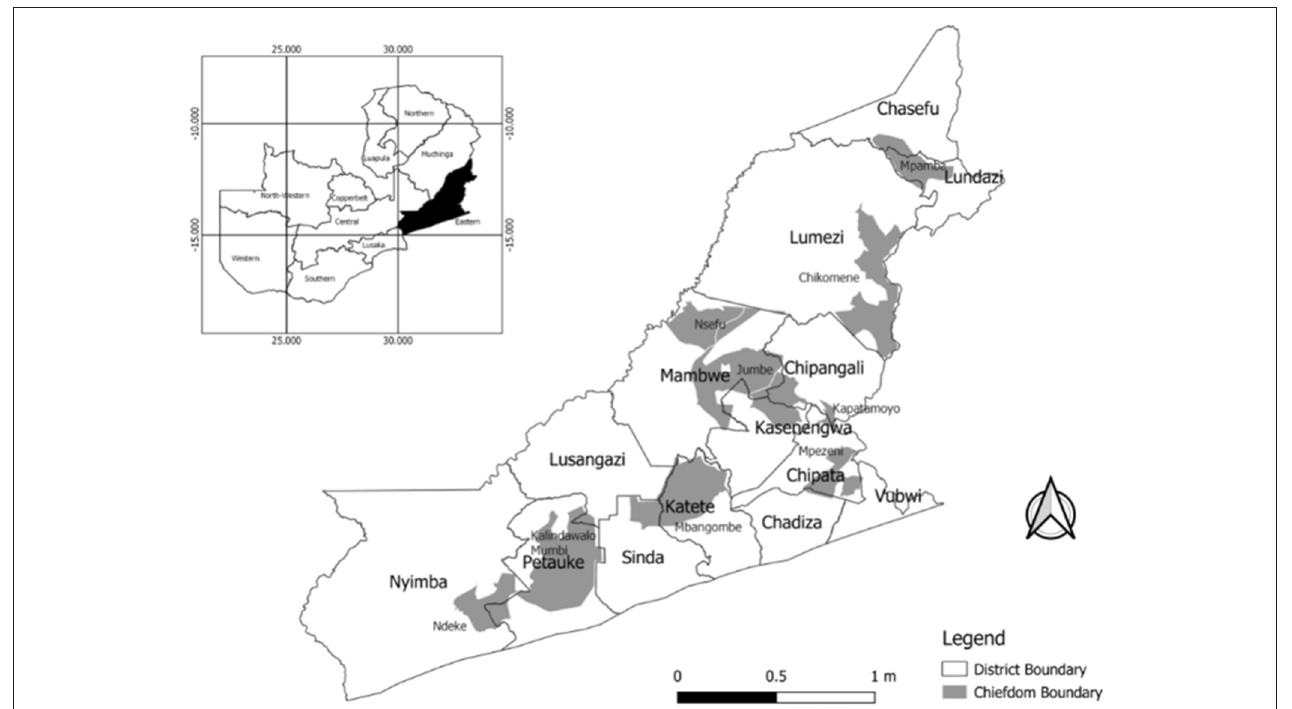
FIGURE 1 | Map of Eastern Zambia showing study districts and study